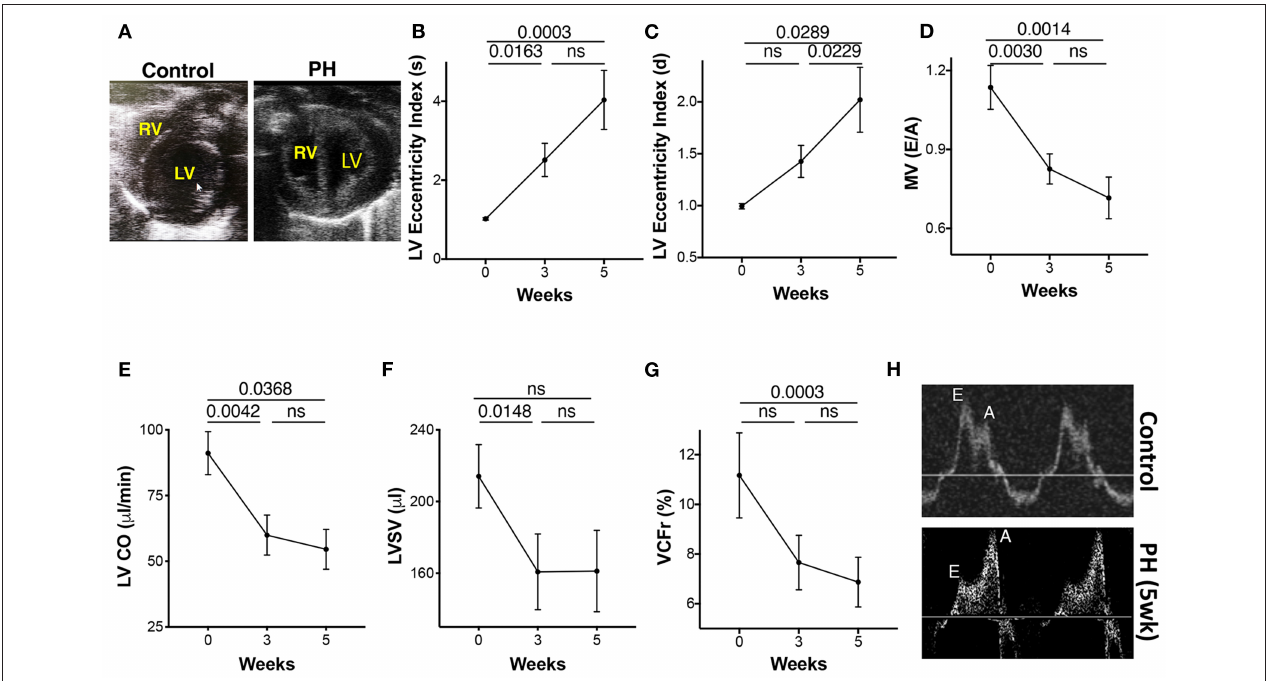
FIGURE 6 | Echocardiographic parameters of the left ventricle (LV) during progression of PAH. (A) Apical view of the chambers showing the RV and LV. LV eccentricity index image showing a reduction in the septolateral diameter in relation to the antero-inferior diameter of the LV. Eccentricity index was calculated from the transgastric midpapillary short axis view as the ratio of the antero-inferior diameter to the septolateral diameter of the LV. (B) LV eccentricity index in systole, (C) LV eccentricity index in diastole, (D) Transmitral ratio of peak early to late diastolic wave velocity, (E) CO, (F) SV, and (G) LV velocity of circumferential shortening as measured from the parasternal long axis view at 0, 3, and 5 weeks of PH induction. (H) Echocardiographic tracings showing mitral valve flow in control (top) and PH (bottom) animals. N = 10